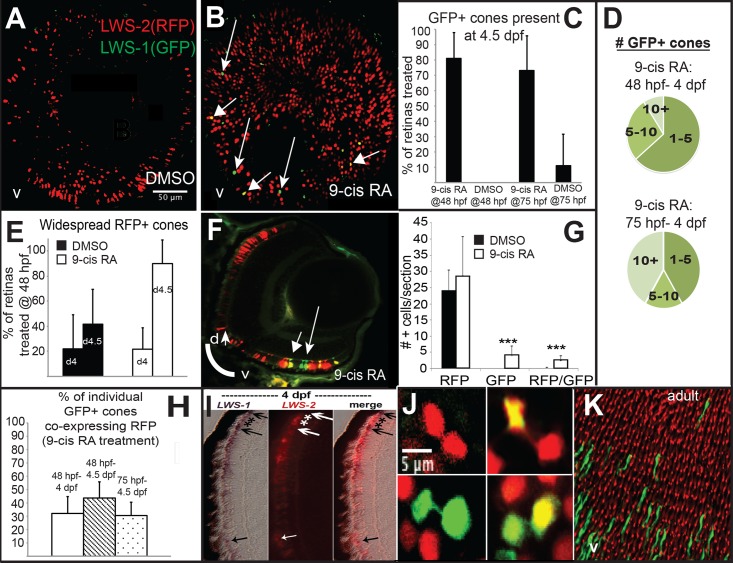
A GFP reporter for LWS1 indicates a switch from LWS2 to LWS1 in response to RA treatment.A-C. Whole mount confocal images of retinas from LWS:PAC(H) embryos treated with DMSO (A) or 0.3 μM 9-cis RA (B) from 48 to 96 hpf. LWS2:RFP+ cones (red) are found in control retinas (A), while cones expressing LWS1:GFP alone (green, arrows) or co-expressing LWS2:RFP and LWS1:GFP (yellow, arrowheads) are found in retinas treated with RA (B); LWS1:GFP expression in transgenic retinas treated with RA tend to appear ventrally and peripherally (B). C. Percentage of retinas examined that contain LWS1:GFP+ cones for DMSO or 9-cis RA treatment 48 hpf to 4.5 dpf and from 75 hpf to 4.5 dpf. Error bars represent 95% binomial confidence interval. D. The pie charts show the frequency of 9-cis RA treated transgenic retinas expressing the indicated number of LWS1:GFP+ cones for treatment 48 hpf to 4.5 dpf (top) or 75 hpf to 4.5 dpf (bottom). E. Graphs show the percentage of LWS:PAC(H) transgenic retinas that contain widespread (covering more than half of the retina) LWS2:RFP+ cones at the indicated time points following treatment beginning at 48 hpf (n = 15, RA 4 dpf; 7, RA 4.5 dpf; 9, DMSO 4 dpf; 4 DMSO 4.5 dpf). Error bars represent 95% binomial confidence interval. F. Indirect immunofluorescence image of a transverse section of an LWS:PAC(H) embryo treated with 9-cis RA. The arrowhead indicates a cone co-expressing LWS1:GFP and LWS2:RFP. The arrow indicates a cone expressing LWS1:GFP. G. Graph indicating the numbers of LWS2:RFP (RFP), LWS1:GFP (GFP), or dual label (RFP/GFP) cones per section in retinas treated with DMSO or 9-cis RA (DMSO vs. 9-cis RA ***, p<0.001; 2-tailed Student’s t-test). H. Individual LWS1:GFP+ cones from retinas treated with 9-cis RA for the indicated time frames were examined for co-expression of LWS2:RFP. I. Dual in situ hybridization for LWS1 and LWS2 after treatment with 9-cis RA from 48 hpf to 4 dpf. Purple color reaction indicates LWS1 expression; pink fluorescent color indicates LWS2 expression; arrows at top show cones expressing LWS1 only; asterisks (*) show cones expressing LWS2 only; arrow at bottom shows cone that is dually labeled. J. Confocal images of pairs of cones at the end of mitosis from whole mount transgenic retinas treated with 9-cis RA from 48 hpf to 4.5 dpf. Apparent daughter cells of cone progenitors were observed expressing the same LWS opsin as well as pairs where one daughter cell also co-expresses a different LWS opsin. K. Confocal image of adult LWS:PAC(H) whole mounted retina showing isolated GFP+ (reporting LWS1) cones.